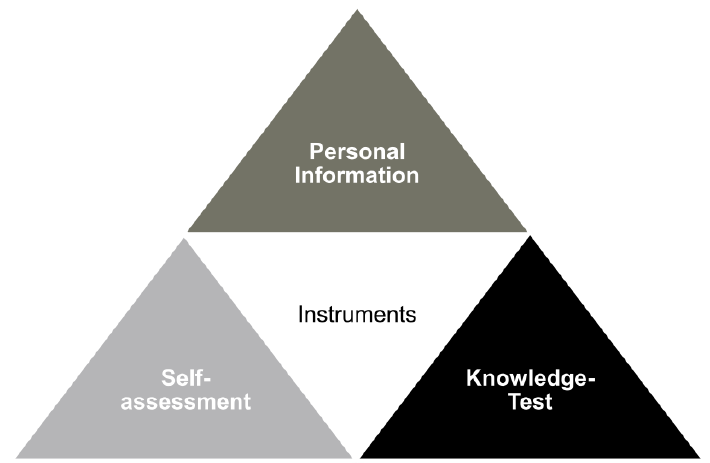
Fig. 1. Tool set of test